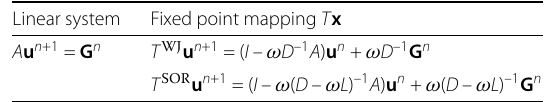
Table 2 The different way of rearranging linear systems (4.5) into the form x = T ( x ) Linear system